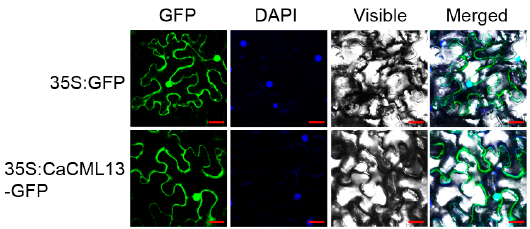
Figure 3. Subcellular localization of CaCML13 in N. benthamiana epidermal cells. N. benthamiana leaves were infiltrated with A. tumefaciens GV3101 cells harboring 35S:CaCML13-GFP (using 35S:GFP as